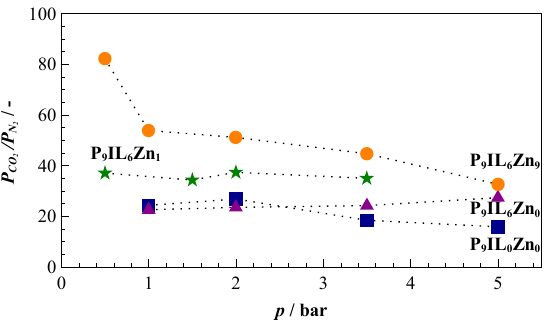
Figure 5. CO 2 /N 2 permeability selectivity calculated from single gas sorption experiments at 20 ◦ C. The black dotted curves provide guides for